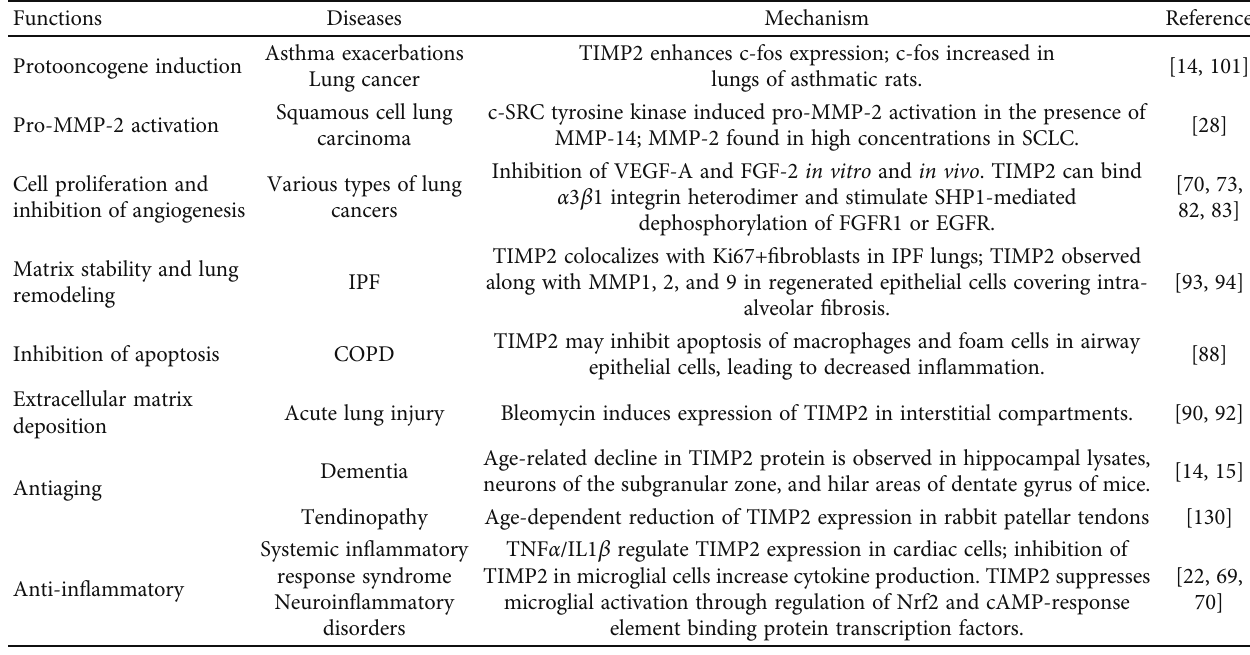
Table 1: Known functions of TIMP2 and corresponding-associated